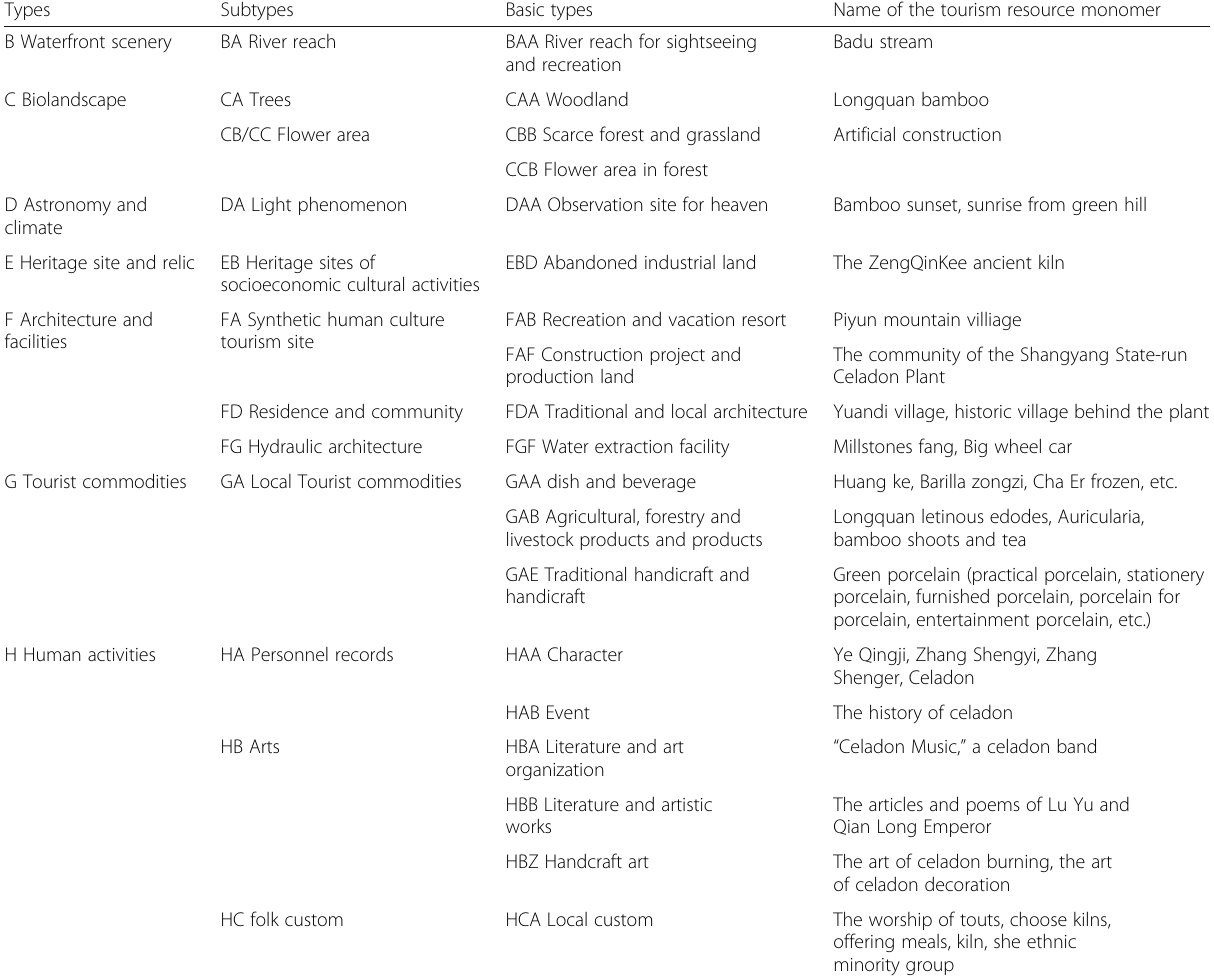
Table 1 The view spots classification of Longquan celadon industry cultural